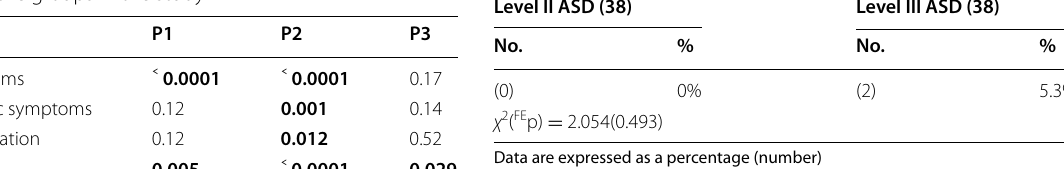
Data are expressed as percentage (number) The P value was generated by Cramer’s V chi-square test